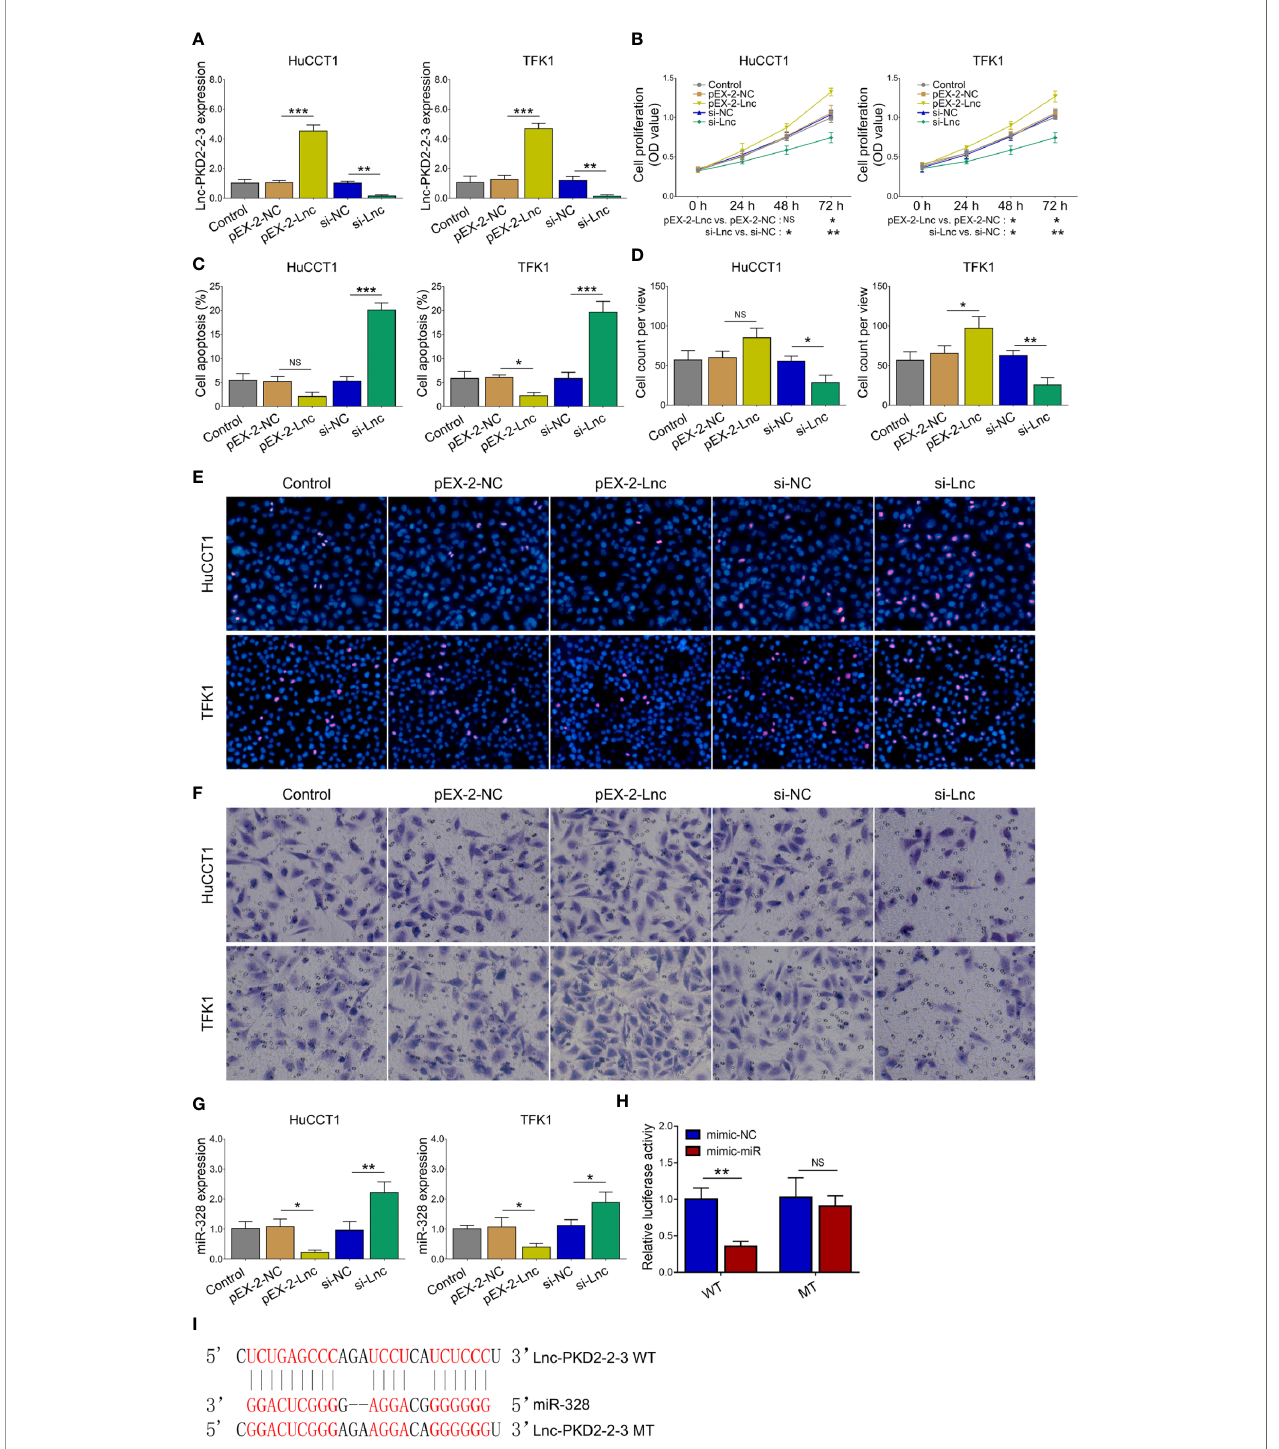
FIGURE 3 | Effect of lnc-PKD2-2-3 on cell proliferation, apoptosis, invasion and miR-328 in CCA cell lines. Lnc-PKD2-2-3 expression (A) , cell proliferation (B) , cell apoptosis rate (C) , invasive cell count (D) , TUNEL image examples (E) , and Transwell image examples (F) among groups after transfection. MiR-328 expression among groups after transfection (G) , relative activity of luciferase gene reporter assay (H) , and bound/designed sequences of lnc-PKD2-2-3 and miR-328 (I) . NS, not signi fi cant; * P < 0.05; ** P < 0.01; *** P <